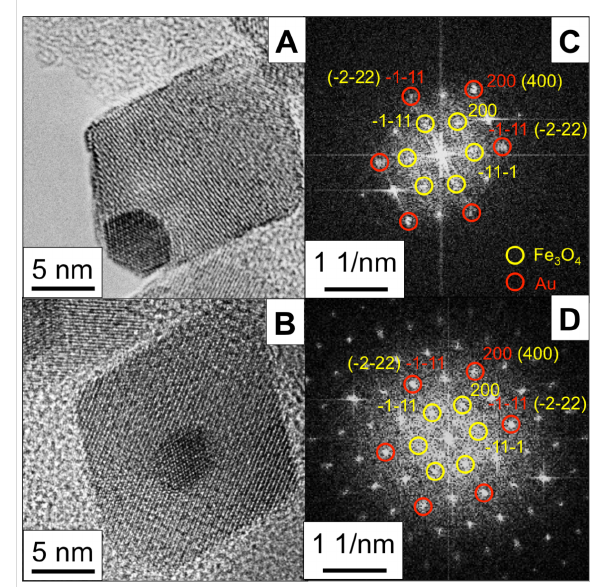
Figure 3: HRTEM and corresponding FTT images of size-selected magnetite–gold NPs: MNP-15 (A, C) and MNP-25 (B, D). Fe 3 O 4 and Au indices are marked yellow and red, respectively. The [111] and [200] crystallographic directions of Fe 3 O 4 and Au register to each other. The NPs are viewed along their [011] direction.